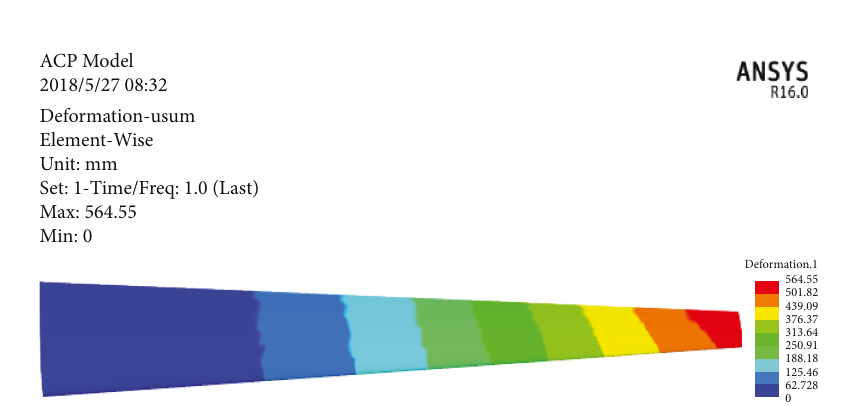
Figure 26: Deformation cloud diagram with the layer angle being ± 45 alone.